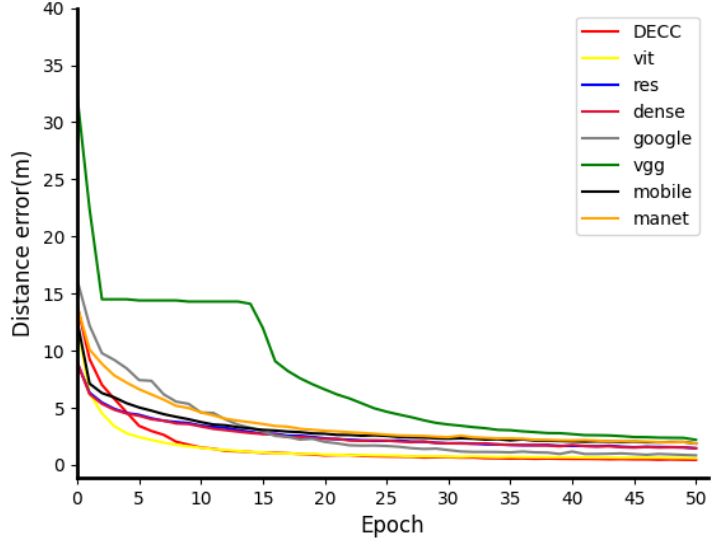
Figure 6. Convergence comparison of the first 50 training epochs of 8